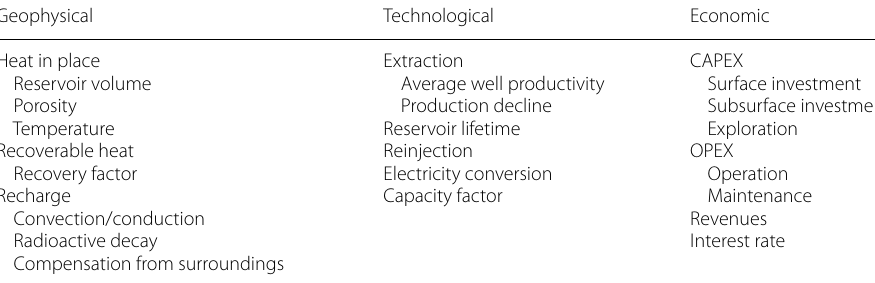
CAPEX capital expenditures, OPEX operating expenditures